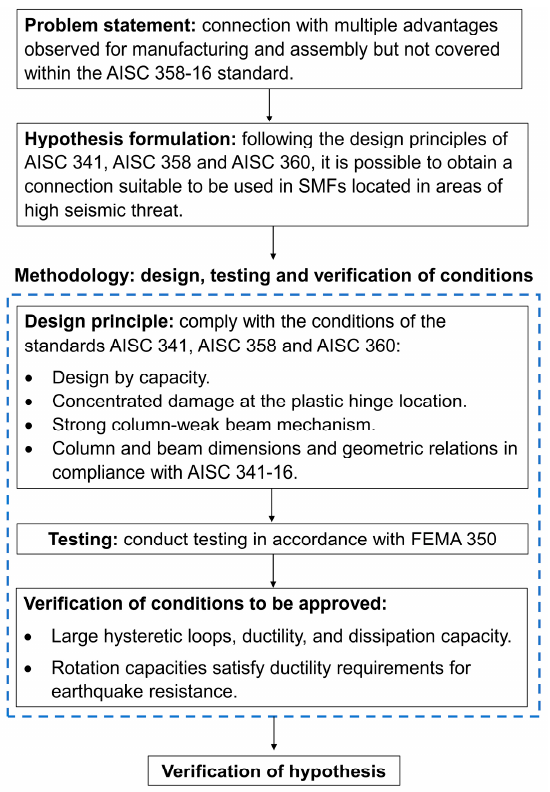
Figure 1. Research framework utilized to evaluate the seismic behavior of the steel beam-to-CFST column connection using external diaphragms.